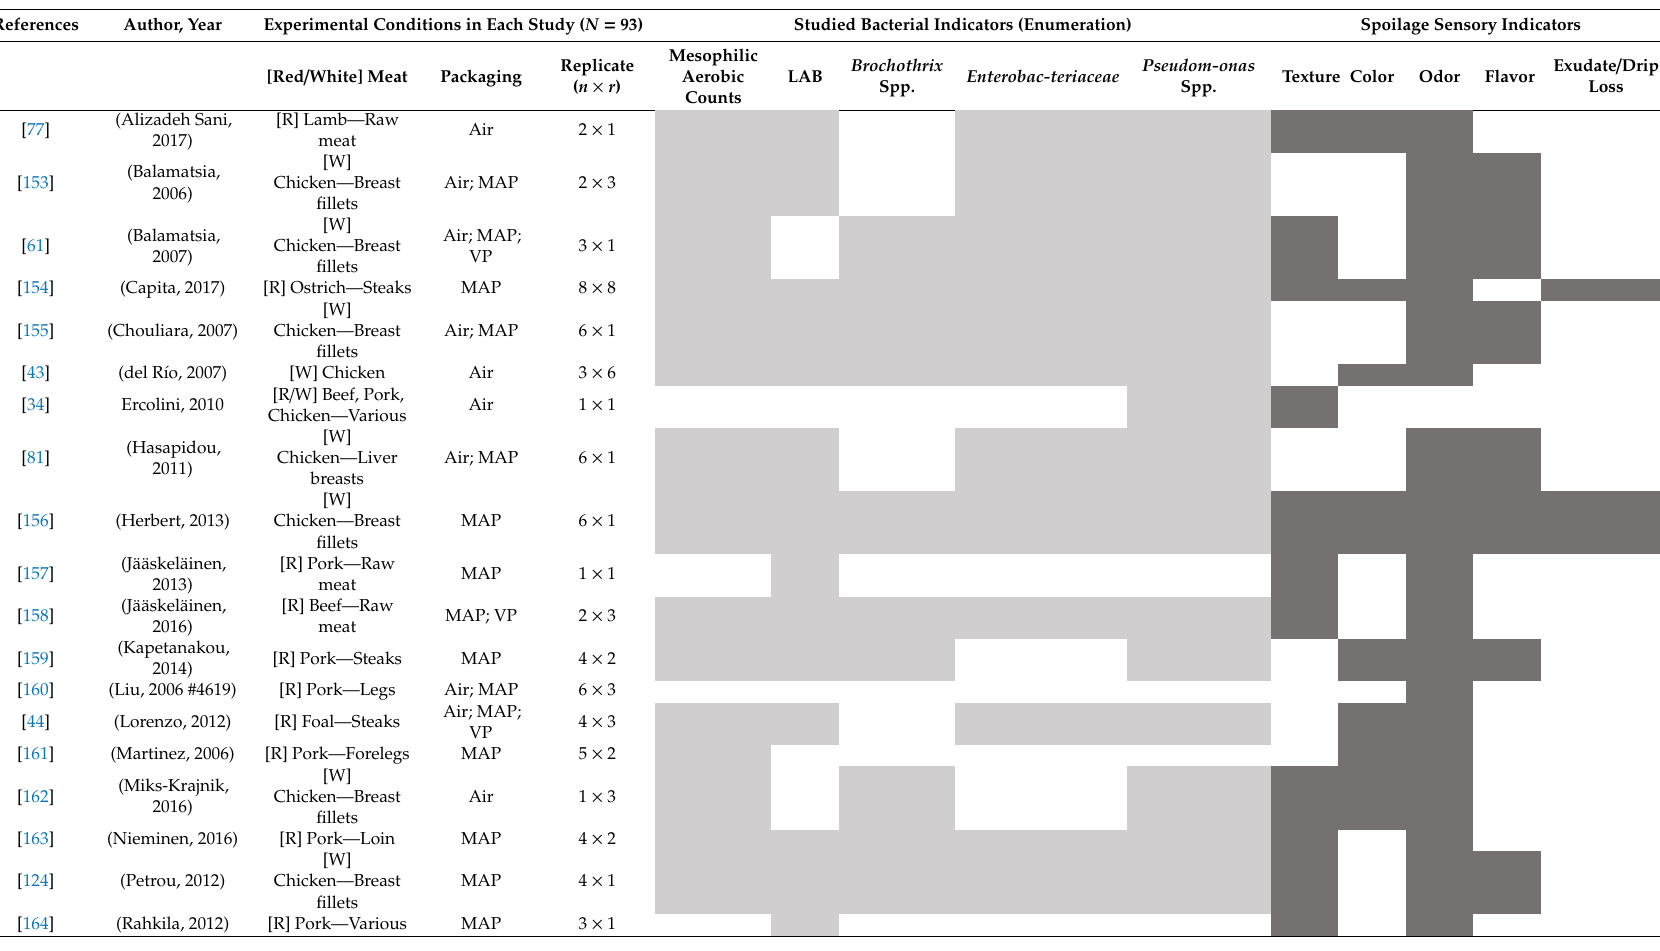
Table 2. Data collected on spoilage occurrence time estimated from di ff erent experimental conditions in 24 studies. The cases filled in light grey correspond to the studied bacterial indicators, those filled in dark grey correspond to the spoilage indicators, i.e., measurement of sensory responses. N, total number of experimental conditions from all studies; n , number of experimental conditions in each study; r , number of replicates for each experimental